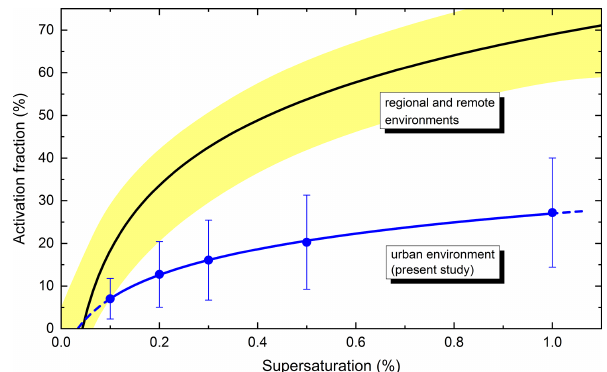
Figure 2. Experimentally determined mean activated fraction of to- tal particles ( N 6–1000 ) and its SD for central Budapest at super- saturations of 0.1%, 0.2%, 0.3%, 0.5% and 1.0% (blue dots) to- gether with the curve fit to the data (blue line). The fitting function used was AF = a × ln (S) + b , with parameters of a = 34 . 8 ± 0 . 4 and b = 26 . 7 ± 0 . 3. The black line, shown for comparison, corresponds to the same fitting function but with mean parameters of a = 22 and b = 69, as obtained for several selected regional and remote sites in a EUCAARI synthesis study (Table 4; Paramonov et al., 2015). The yellow band represents the 95% confidence interval.